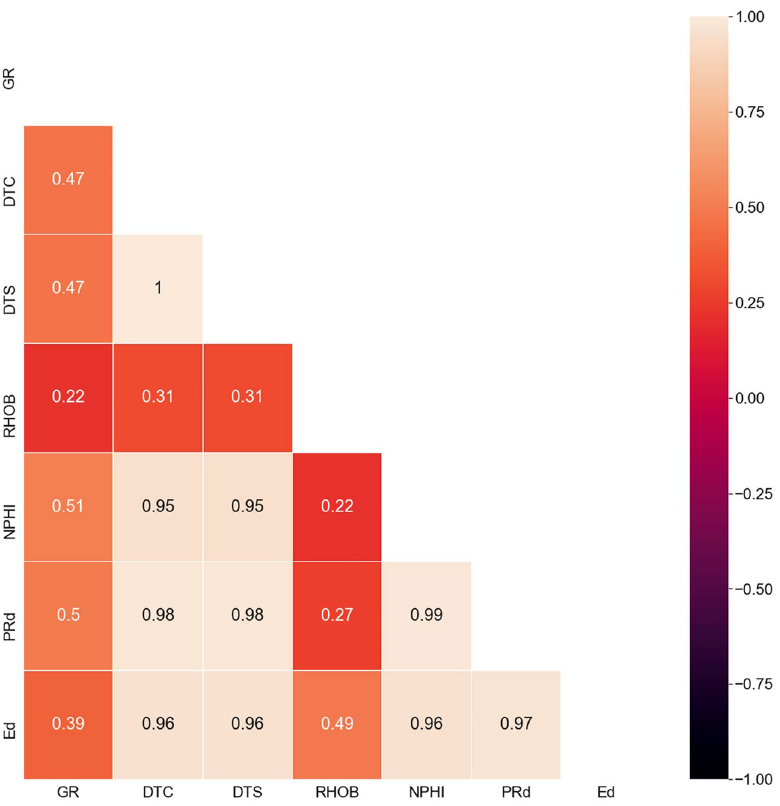
Figure 1. A heat map for the absolute value for the correlation coefficient between the input parameters with each